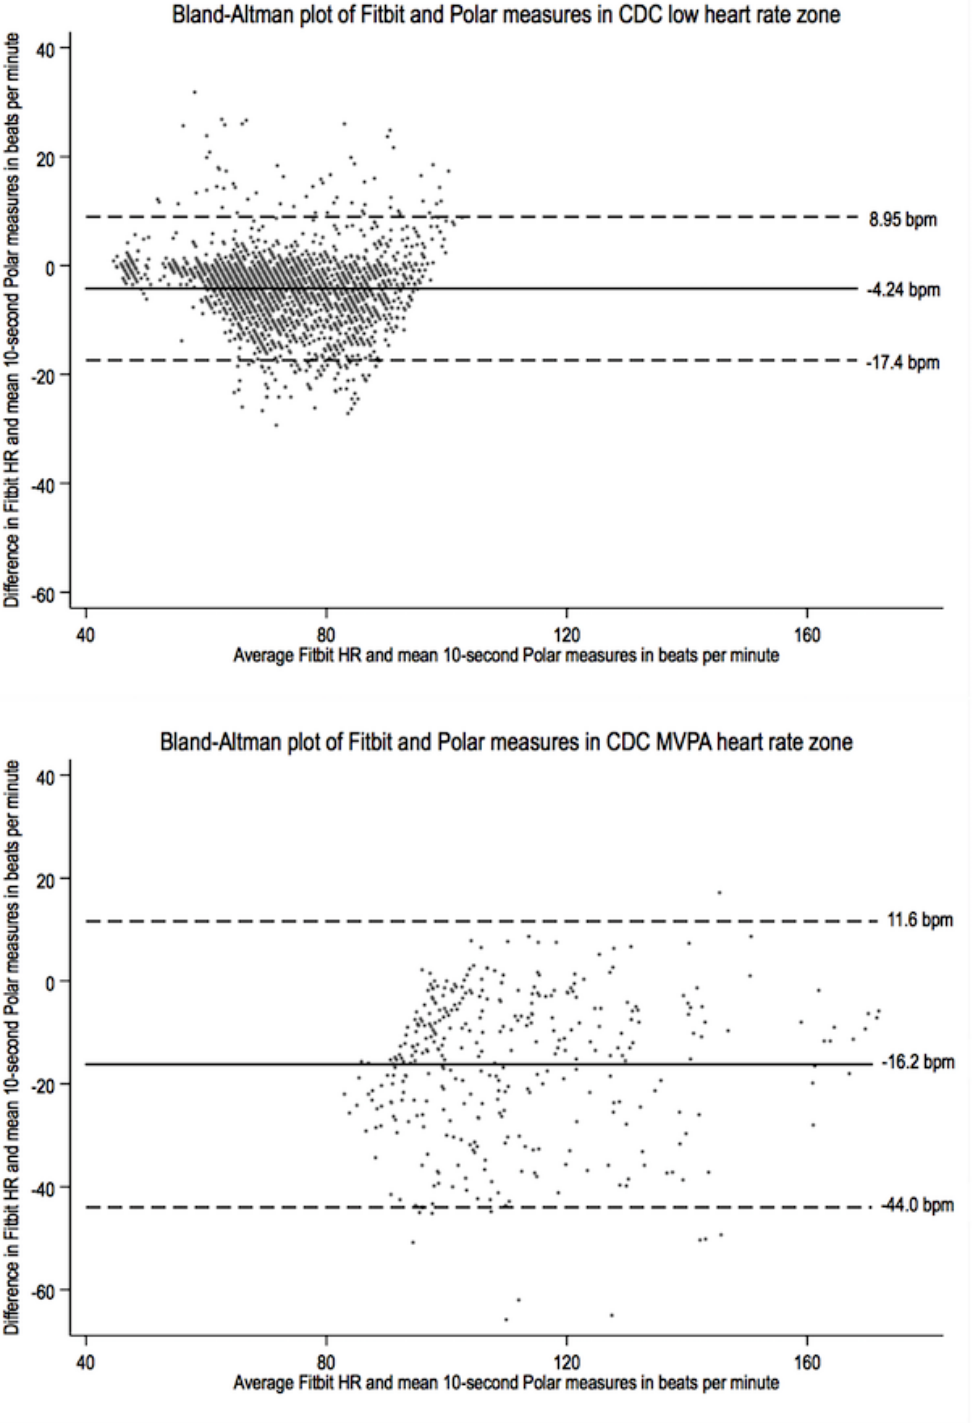
Figure 3. Bland-Altman plots for paired measures in low (top) and moderate to vigorous physical activity (MVPA; bottom) Centers for Disease Control and Prevention (CDC) heart rate